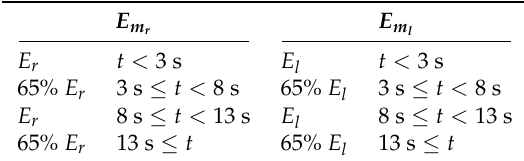
Table 3. Abrupt changes in E r and E l